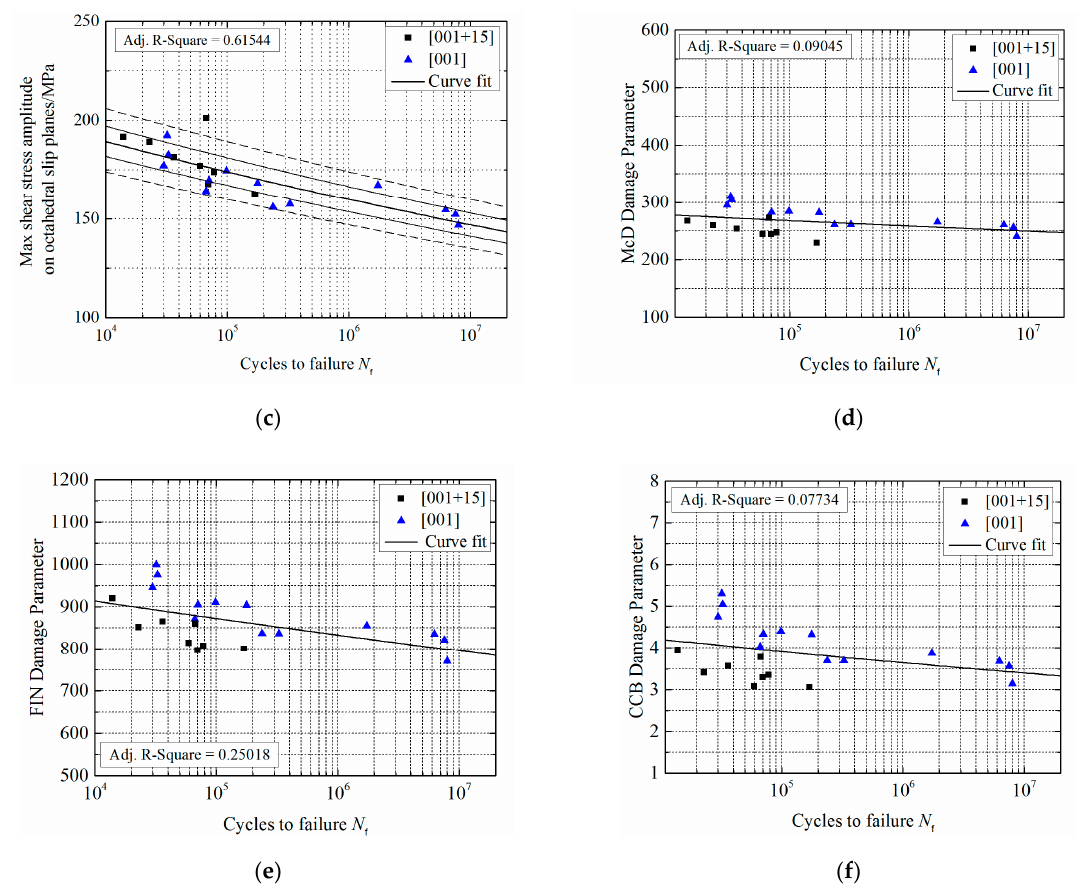
Figure 8. Fatigue life predictions for PWA1484 material at 593 °C: ( a ) stress amplitude; ( b ) maximum resolved shear stress amplitude; ( c ) maximum resolved shear stress amplitude (primary octahedral slip system); ( d ) McD model; ( e ) Fin model; ( f ) CCB model.